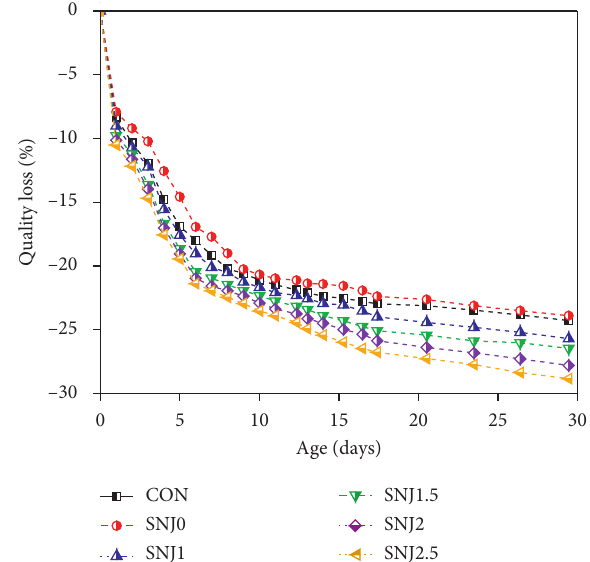
Figure 5: Quality loss curves of dry shrink test